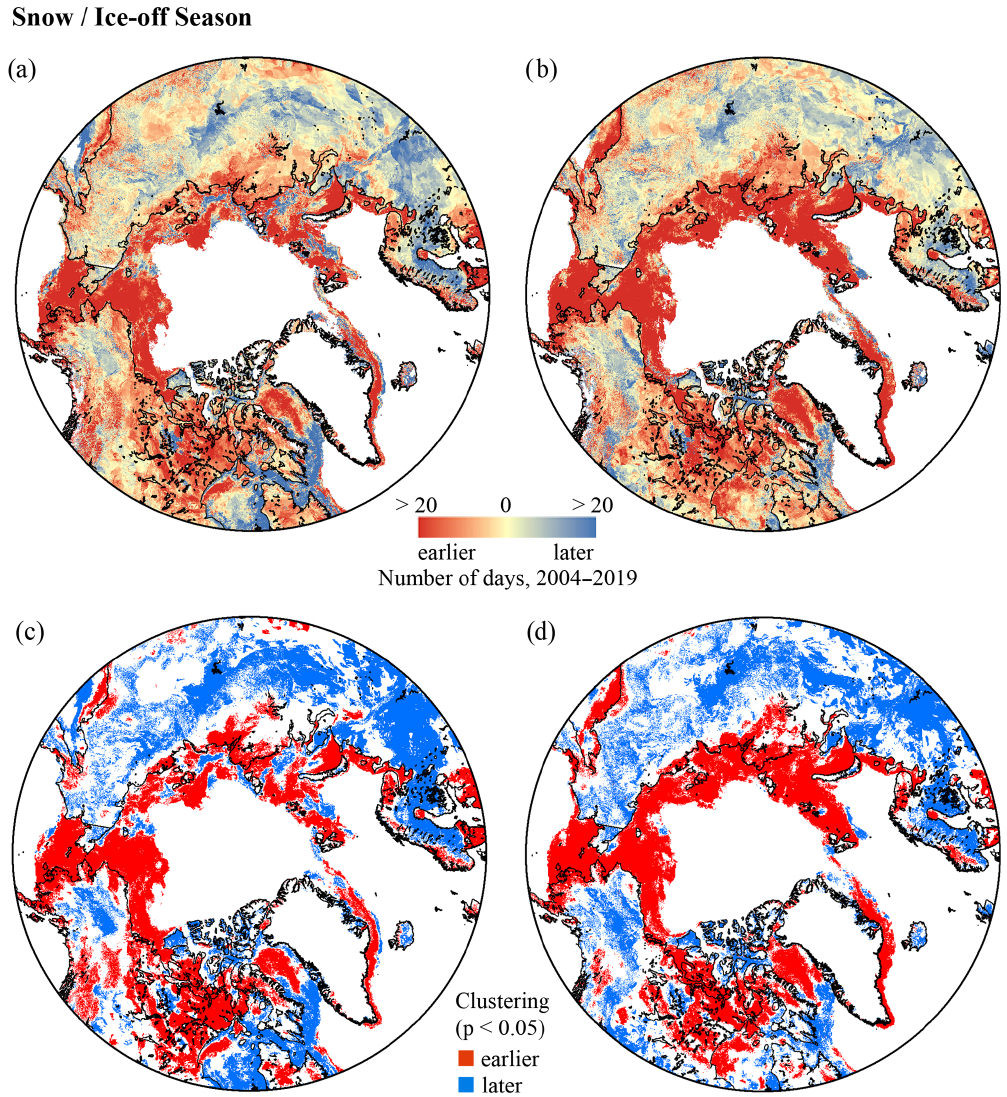
Figure 6. Trends in 4km IMS (2004–2019) (a) sea ice first open water (FOW S ), first snow-off (first_s OFF ), and lake ice first open water (FOW L ); (b) sea ice water clear of ice (WCI S ), final snow-off (final_s OFF ), and lake ice water clear of ice (WCI L ); (c) significant trend clusters in FOWs, FOW L , and first_S OFF ; and (d) significant trend clusters in WCI S , WCI L , and final_S OFF